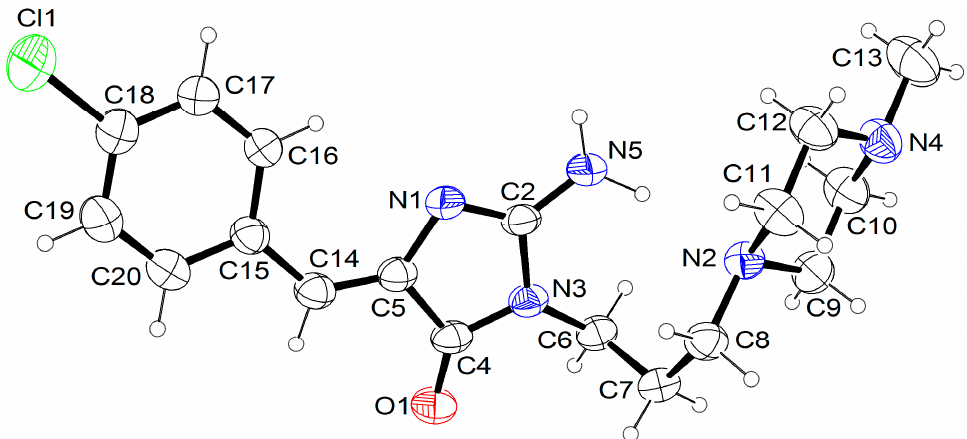
Figure 3. Atom numbering scheme of compound 7 . Displacement ellipsoids are drawn at the 30% probability level.